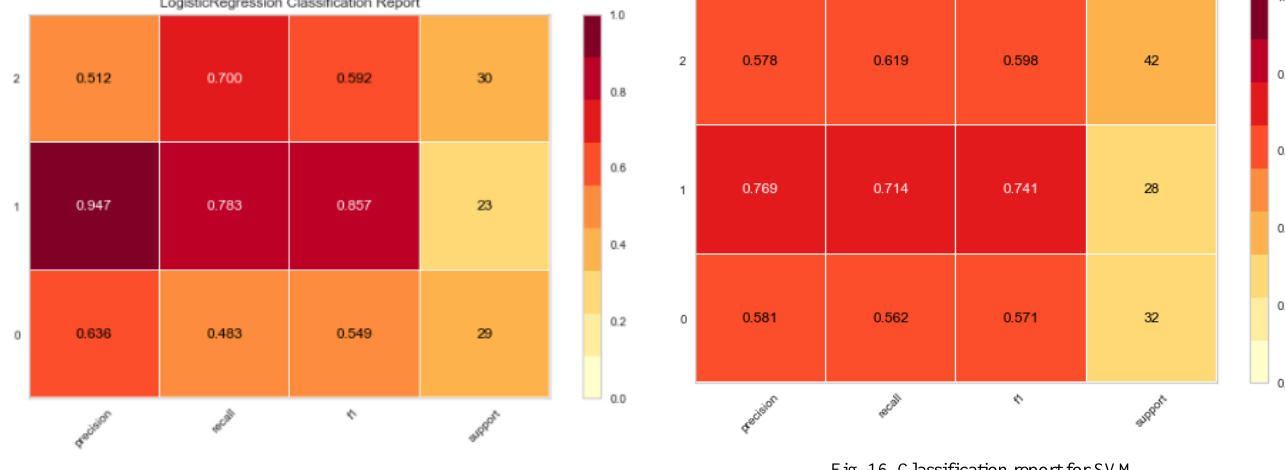
Fig. 13. Classification report for LR.